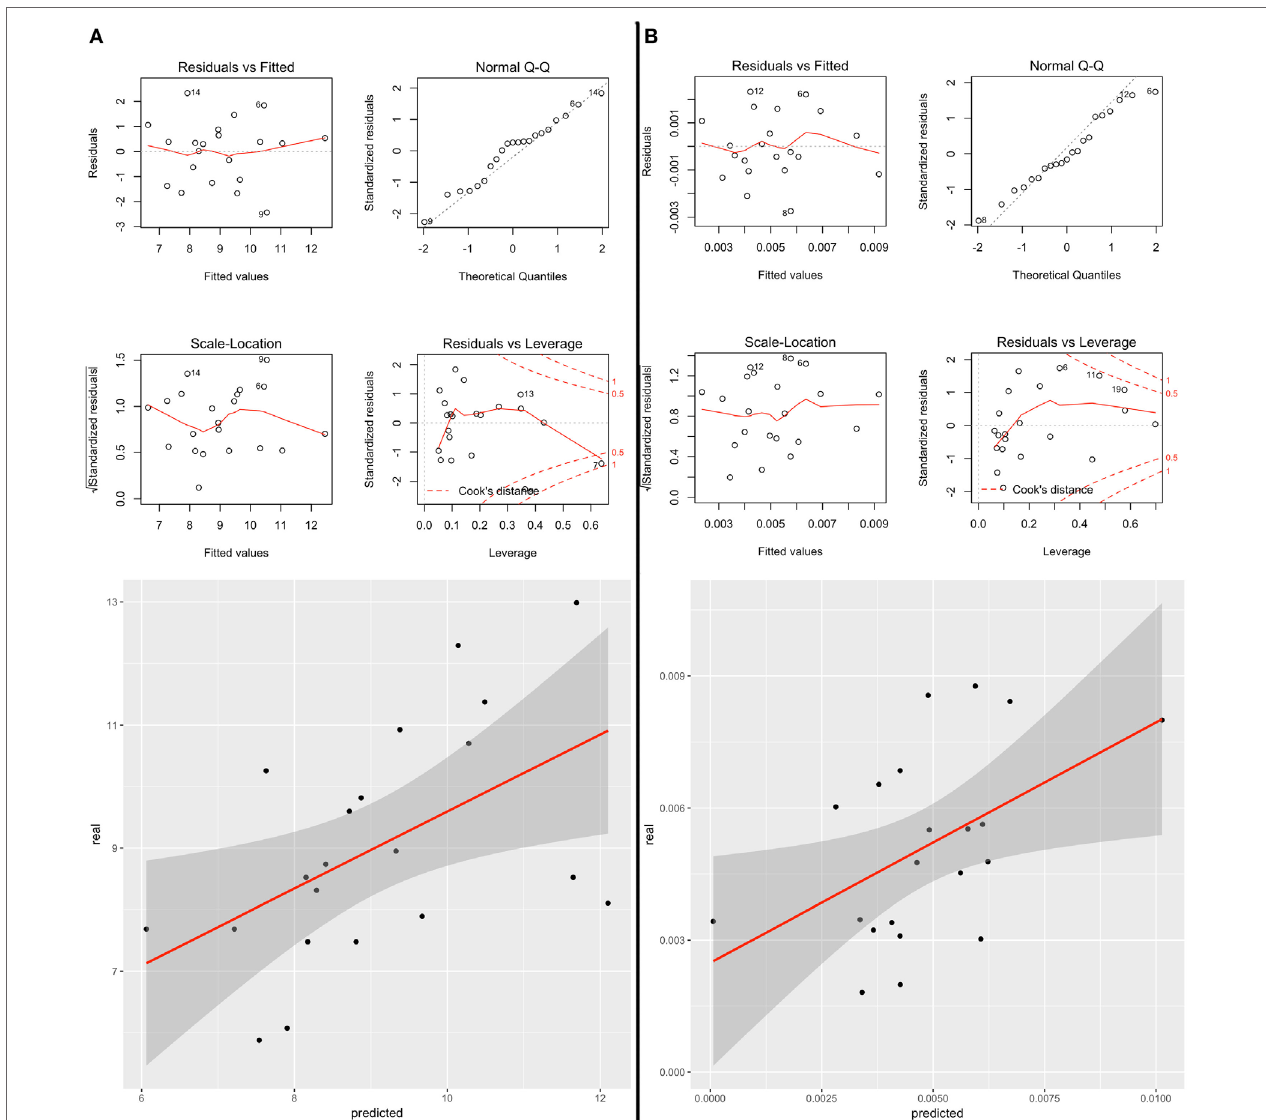
FigUre 6 | (a) Correlation between predicted and real measurements of (A) SRT-CLTR z -score and (B) TWT after leave-one-out cross validation. (B) Diagnostic plots shows: (i) residuals function of fitted values (upper left), (ii) the hypothesis of normal distribution of the errors with QQplot (upper right), (iii) that the variance in the Residuals does not change as a function of z -score (bottom left), (iv) and the presence of outliers with Residuals function of Leverage (bottom